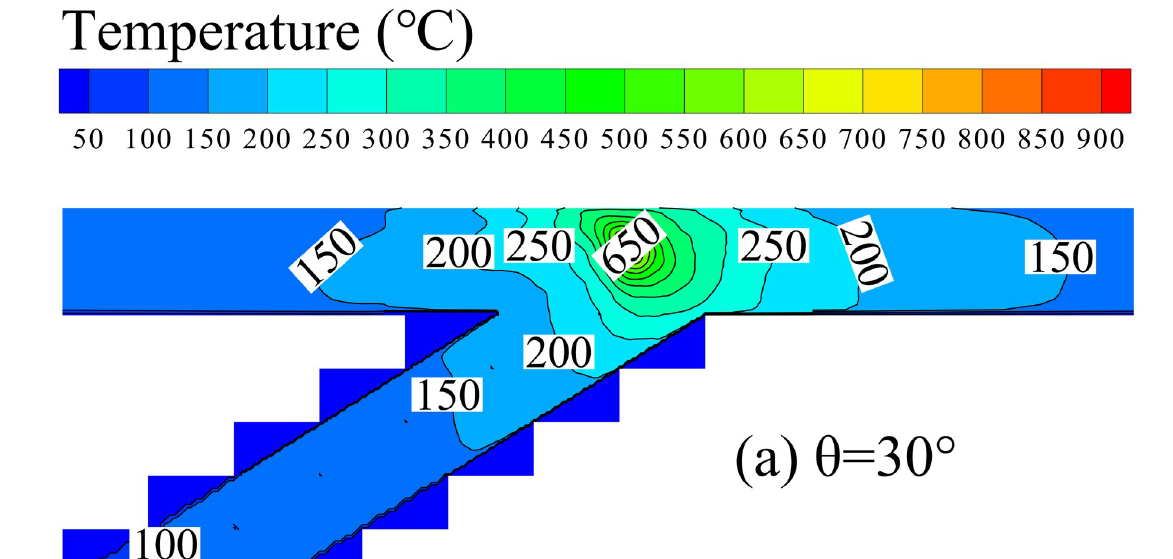
Fig 6. Temperature contours for various bifurcation angles at HRR of 20 MW (top view).